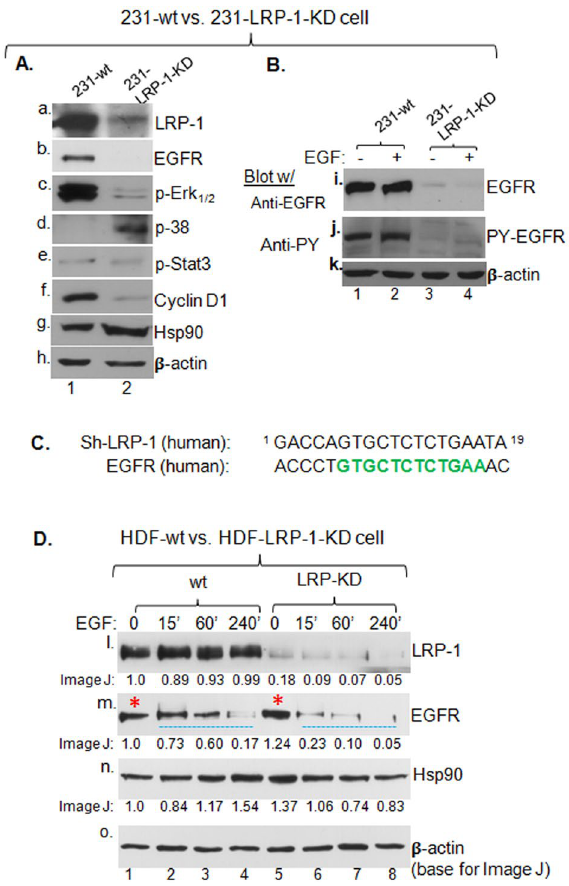
Figure 5. LRP-1 downregulation destabilizes activated EGFR in both tumour and normal cells. ( A ) Total lysates of 231-wt and 231-LRP-1-KD cells were immunoblotted with indicated antibodies to show that downregulation of LRP-1(panel a) caused disappearance of EGFR (panel b) and affected known EGFR downstream targets, but not other controls (panels c to g). ( B ) Total cell lysate of the two cell lines with or without hrEGF (100 ng/ml) stimulation for 2 min were blotted with either anti-EGFR protein (panel i) or anti-phosphotyrosine (PY) (panel j) antibody. ( C ) The best continuous nucleotide sequence match between the target sequence of shRNA against LRP-1 and the human EGFR cDNA is shown. ( D ) Primary human dermal fibroblasts with or without down- regulated LRP-1were stimulated with hrEGF (100 ng/ml) for indicated times. O.D. equalized total cell lysates were subjected to Western immunoblotting analysis with indicated antibodies. The intensity of the signals was measured by Image J, based on their corresponding β-actin band signals. Asterisks indicate inactivated EGFR proteins, indicating no cross reactivity from the